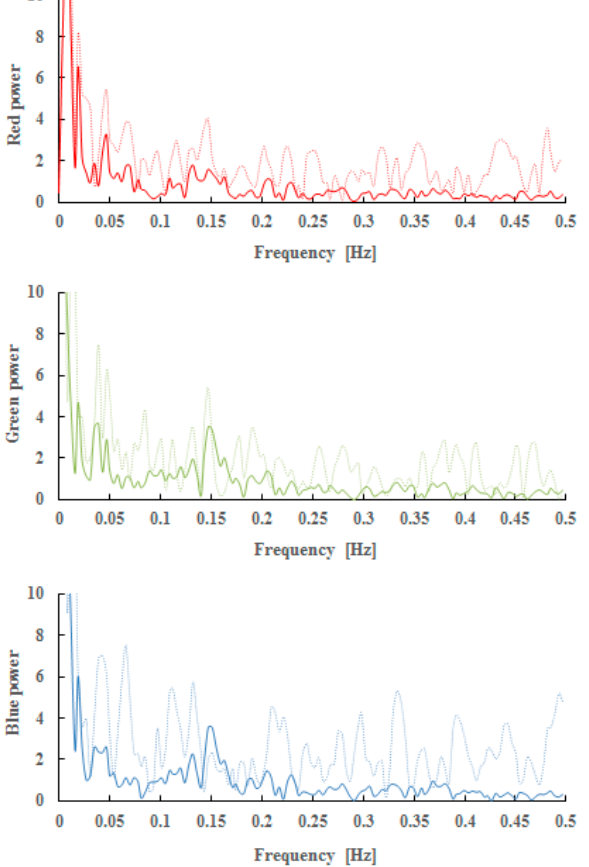
Figure 8. Power spectrum calculated from time series of the RGB average values (solid line: r = 0, dot line: r = 15).